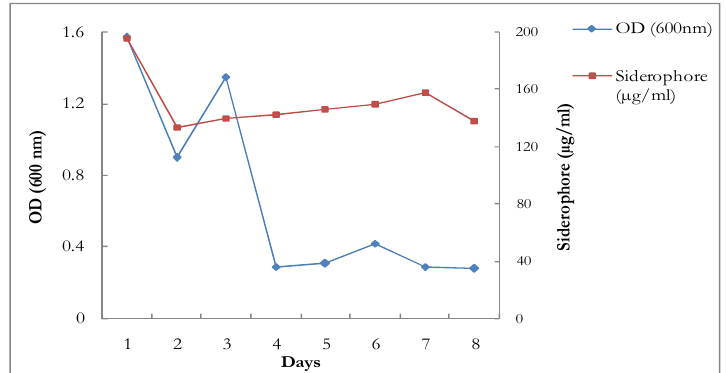
Figure 3. Temporal effect on growth and siderophore production